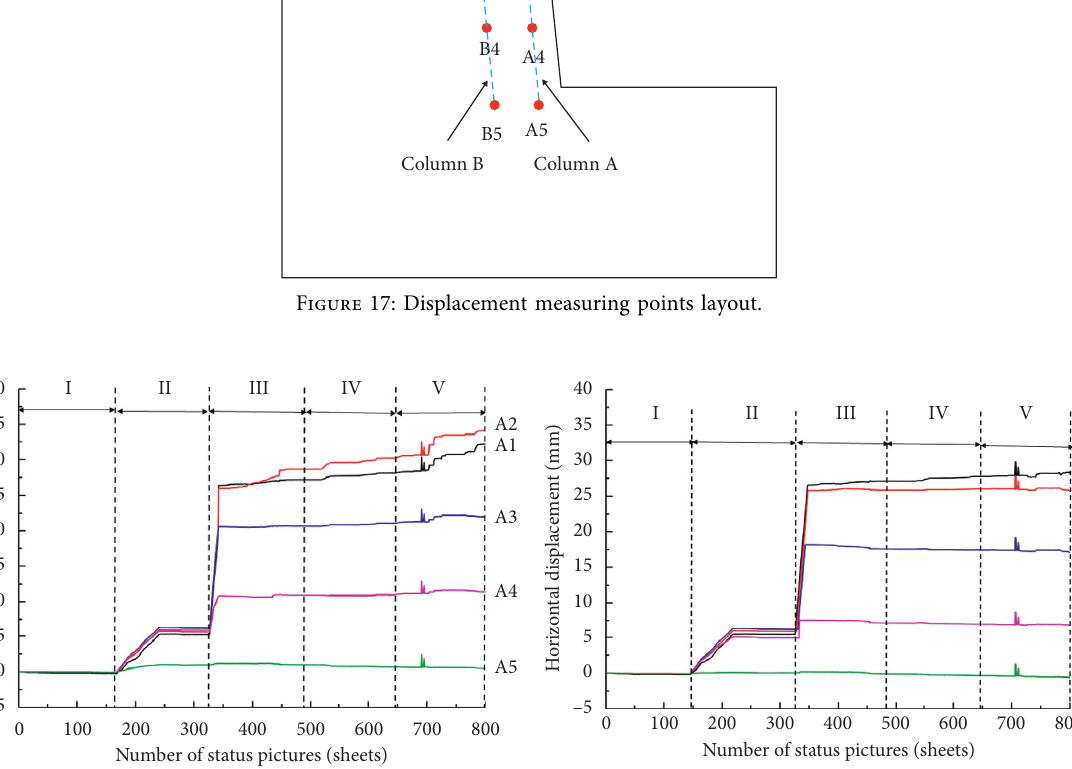
Column B Column